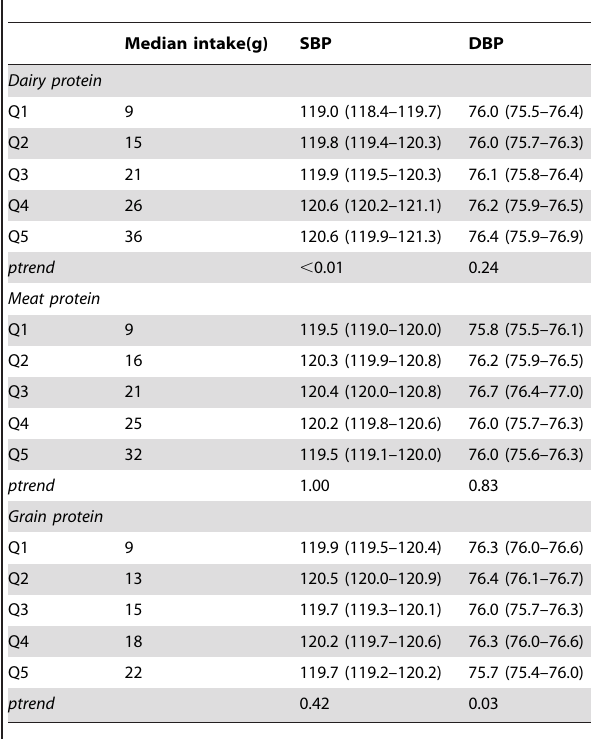
Table 3. Fully adjusted systolic and diastolic BP in 20,820 untreated Dutch adults in quintiles of dairy, meat and grain protein